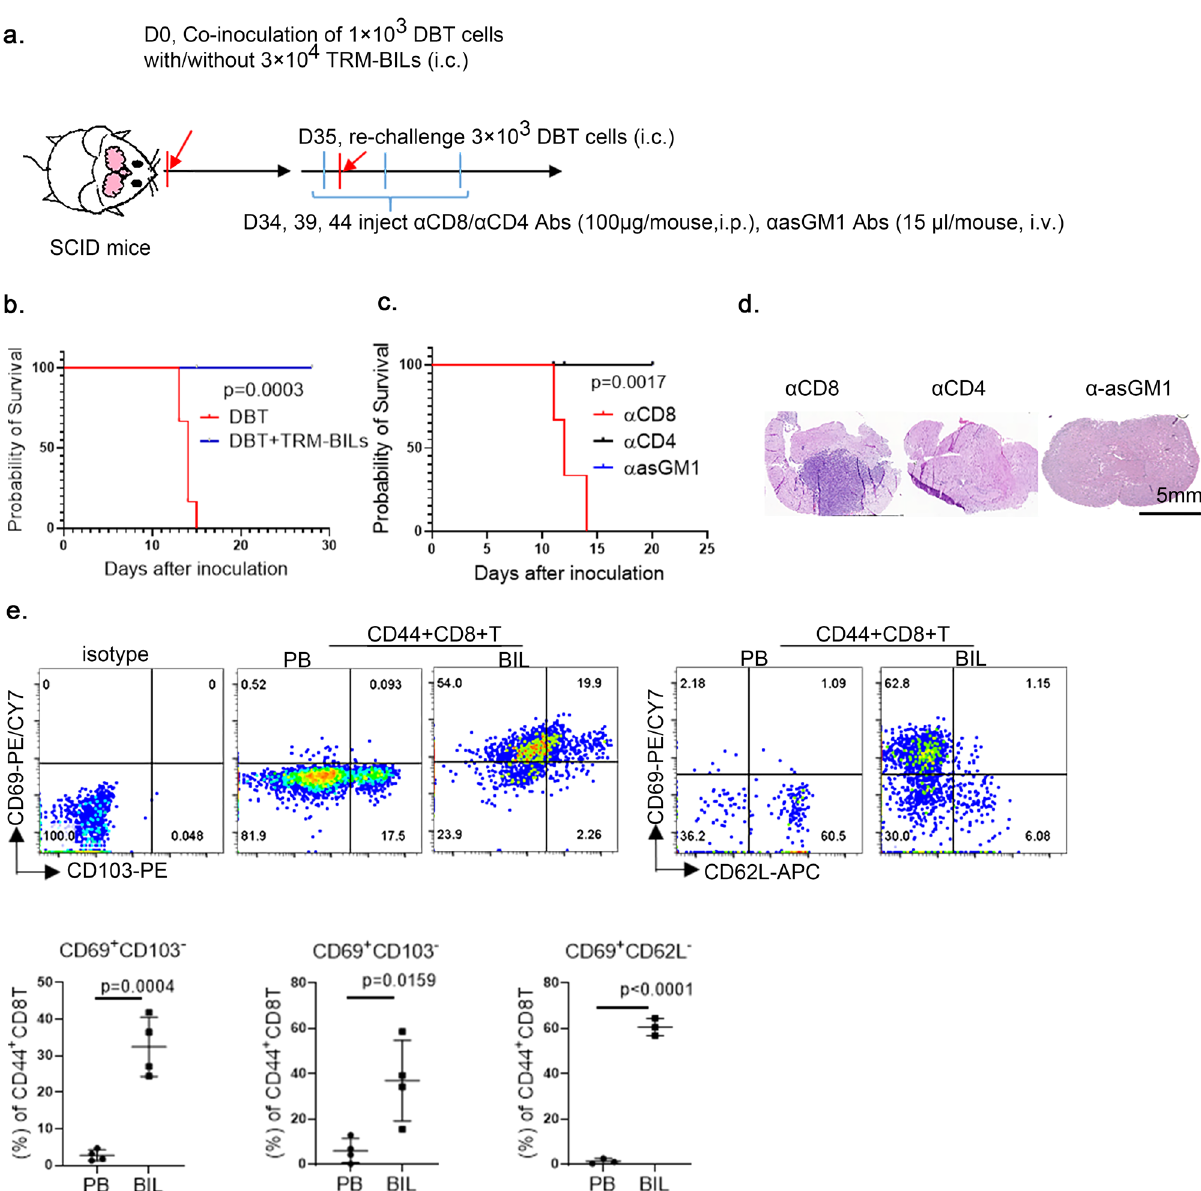
Fig. 5 | T RM -like cells were CD8 + T cells and exhibited T RM phenotypes. a Schematicofexperimentaldesign.Onday7afterthethirdtumorcellrechallenge, 3×10 4 T RM- containing brain-in fi ltrating lymphocytes (T RM -BIL) from T- α FGL2 – treated survivors were sorted by fl ow cytometry and co-inoculated i.c. along with3×10 3 DBTcellsinto naïve SCID mice;35 days after transplantation,the SCID mice bearing transplanted T RM -BILs were rechallenged with 3×10 3 DBT cells i.c., combined with antibodies blocking CD8, CD4, or asGM1 i.p. b Kaplan-Meier survival curves of mice in ( a ) ( n =6 mice/group), log-rank test. c Kaplan – Meier survivalcurvesofmicetreatedwithanti-CD8,anti-CD4,oranti-asGM1antibodiesin